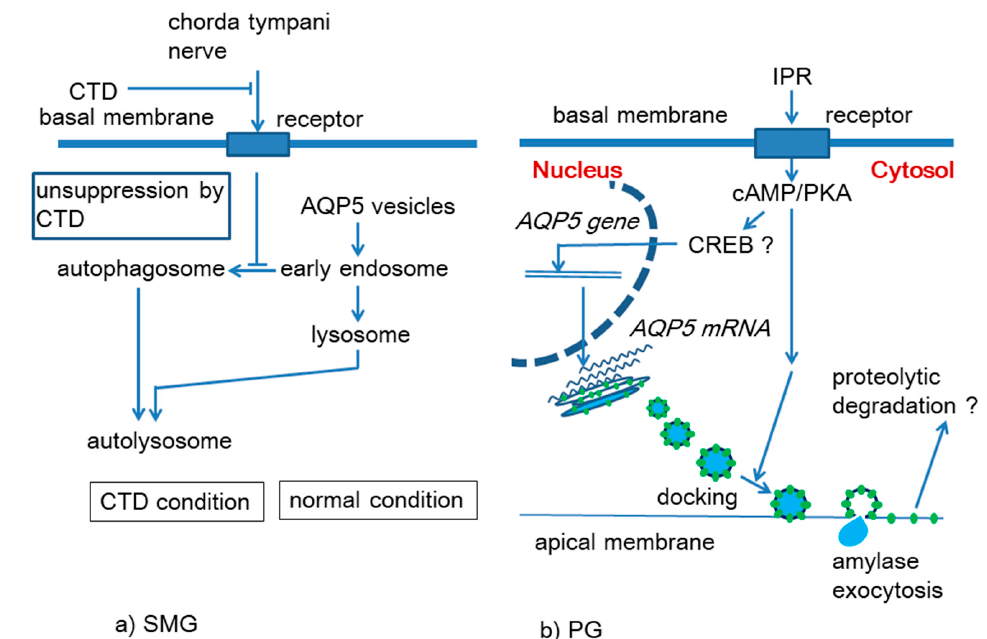
Figure 2. Hypothetical mechanism for regulation of salivary gland AQP5 by the autonomic nervous system and chemical transmitters. ( a ) Suppression of autophagosome activation by chorda tympani nerve leading to maintenance of membrane AQP5 levels in the rat SMG. Chorda tympani denervation (CTD; parasympathectomy) un-suppresses autophagosome activation leading to degradation of AQP5; ( b ) IPR-induced increase in the membrane AQP5 protein and AQP5 mRNA in the PG of mice. Green dots in this figure represent AQP5 protein molecule.